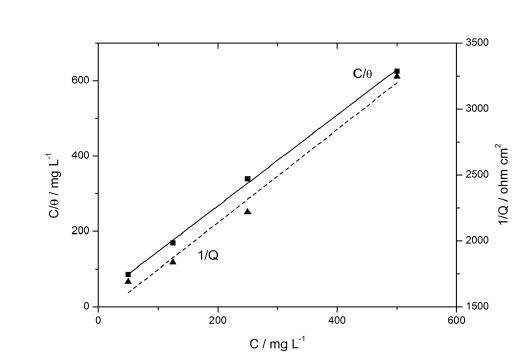
Figure 8: Langmuir adsorption isotherm of of methanolic Bauhinia purpurea extract on the C‑steel surface in 1.0 mol·L -1 H relation with methanolic Bauhinia purpurea extract